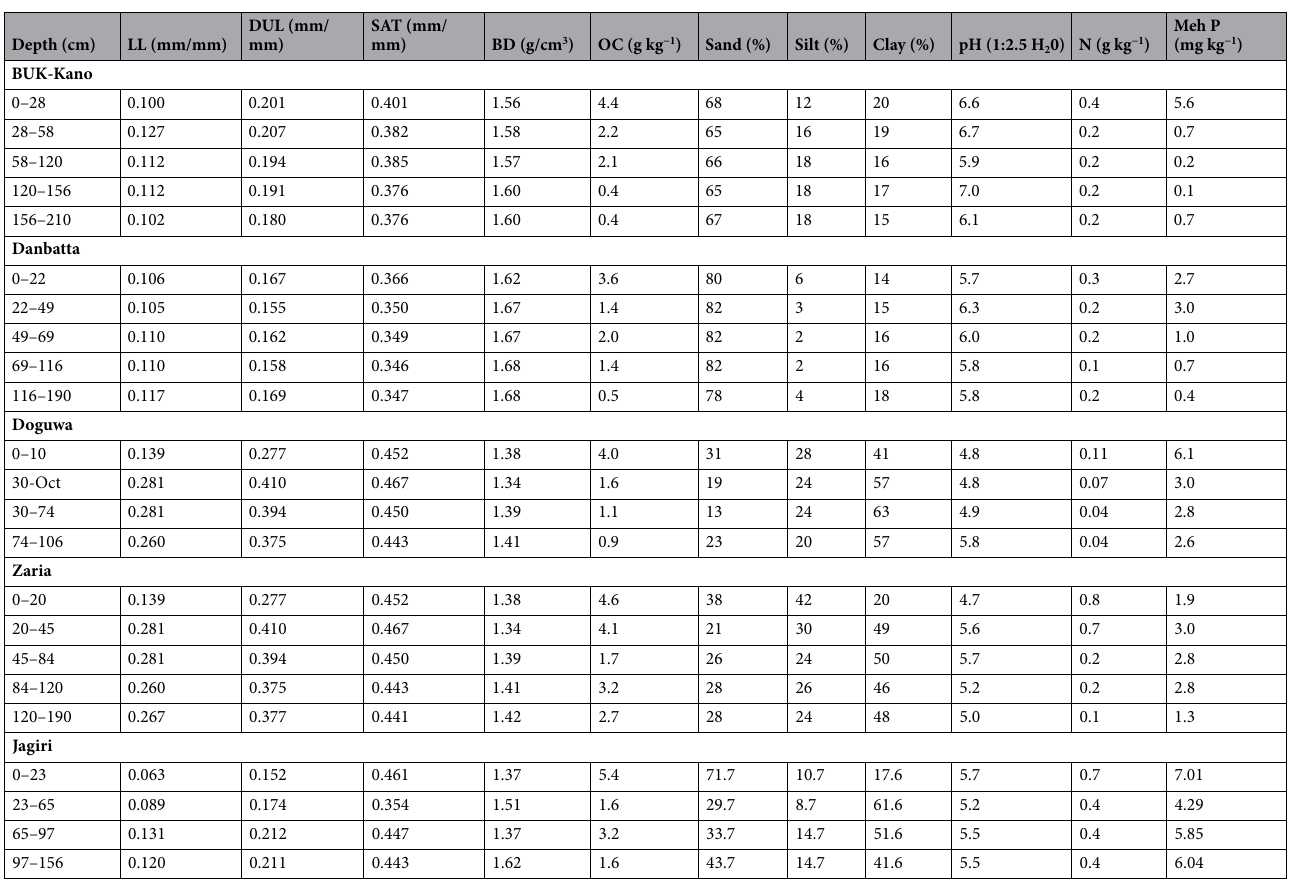
Table 1. Soil physical and chemical properties of pedons used for calibration, evaluation and model applications in the Sudan savanna and northern Guinea savanna of Nigeria. LL lower limit, DUL drained